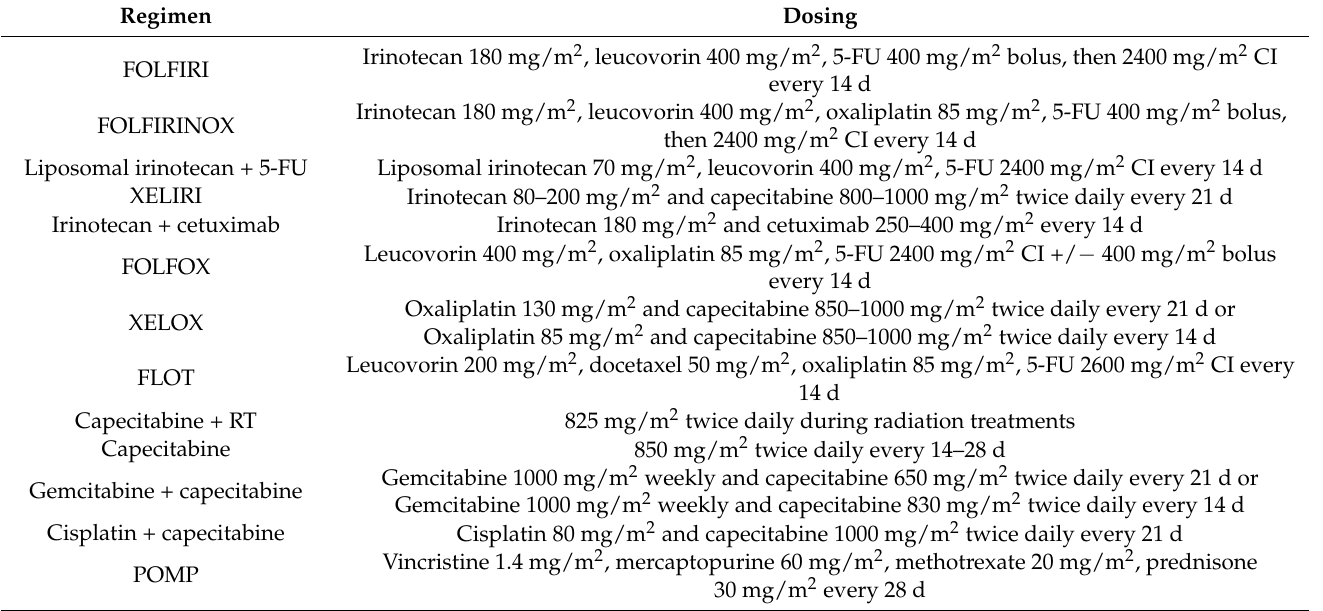
Table A3. Pharmacogenomically-relevant treatment regimens with associated